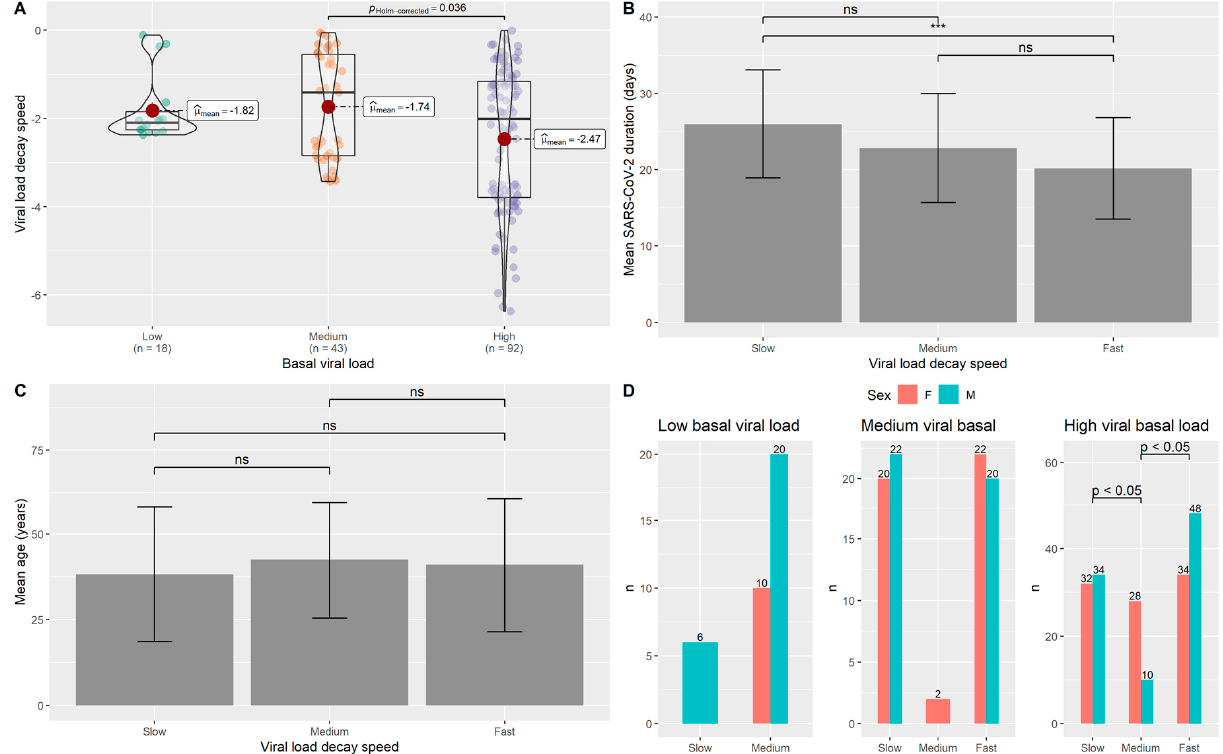
Figure 3. Analysis of the α V carriers group. ( A ) VLDS showed to be dependent on the basal viral load, proving the need of stratifying according to viral load inside the group. ( B ) The duration of infection significantly differs between individuals with slow and fast VLDS. ( C ) Age did not show a significant difference with respect to individuals with different VLDS. ( D ) Sex distribution was different among individuals with a high viral load. Male sex was found to be significantly different between the individuals characterized by fast and medium as well as slow and medium VLDS. n = number of subjects; *** p < 0.001; ns : not